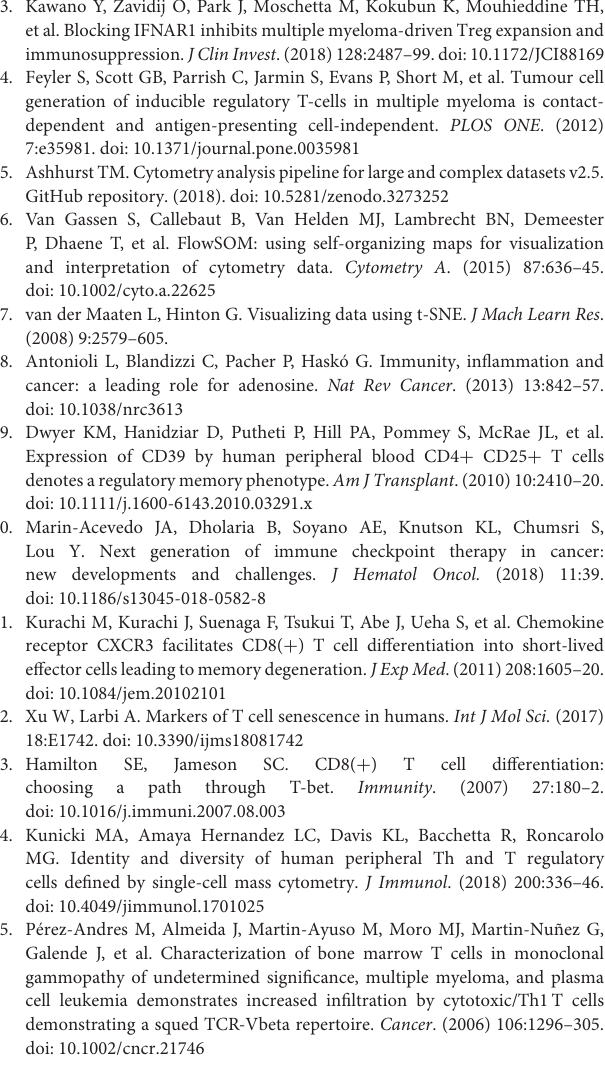
Figure S2 | Treg compartment of MGUS and NDMM patients displayed in 25 phenotypically different MC generated by the FlowSOM (seed B). Data presented as in Figure 3 (A–C) (FlowSom seed A) demonstrating reproducibility in terms of MC size and phenotype across seed changes (Seed A vs. seed B). MC15 and MC23 depicted in Seed A ( Figure 3 ) correspond to MC21 and MC1 depicted in Seed B, respectively. Figure S3 | Activated CD39 − Treg and BM-resident CD39 − Treg emerge in NDMM patients (seed B). Data presented as in Figure 4 (A–D) (FlowSom seed A) demonstrating reproducibility in terms of MC size and phenotype across seed changes (Seed A vs. seed B). MC15 and MC23 depicted in Seed A ( Figure 4 ) correspond to MC21 and MC1 depicted in Seed B, respectively. Table S1 | Patients and HD characteristics and assay used for each subject included in study. Table S2 | List of antibodies, clones, and conjugates used for mass cytometry staining and data